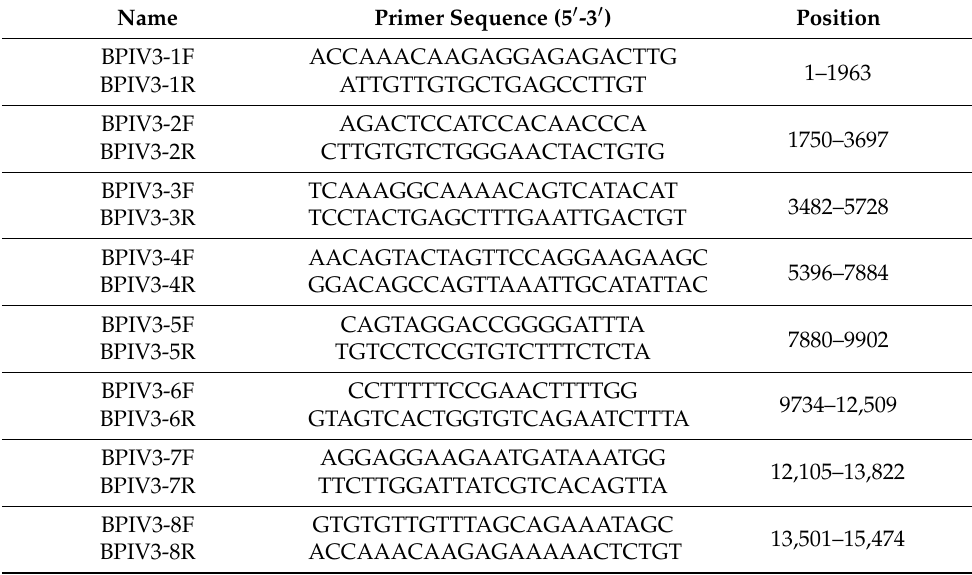
Table 2. PCR primers for complete genome amplification of